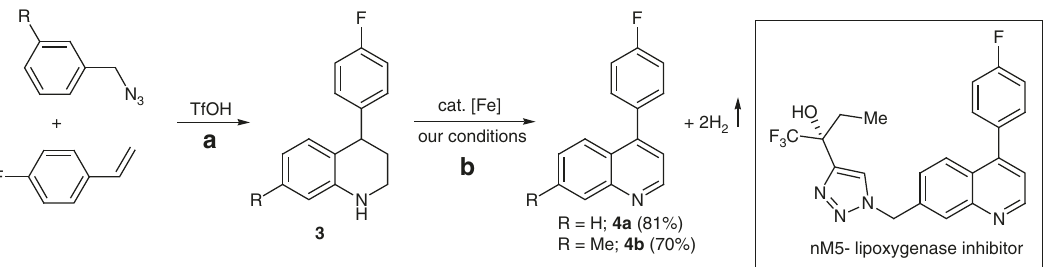
Fig. 7 Synthesis of precursor ( 4 ) for nM5- lipoxygenase inhibitor. a Reaction conditions: To a 20 mmol of benzyl azide (in dichloromethane) was added TfOH (1.1 equiv.) followed by 4- fl uorostyrene (2.0 equiv.) at 0 °C and allowed to stir for 1 h. b Reaction conditions: 3 (0.2 mmol), cat. Fe-L 1 @EGO-900 (8 mol%), t -BuOK (10 mol%), and mesitylene (2 mL) heated at 145 °C for